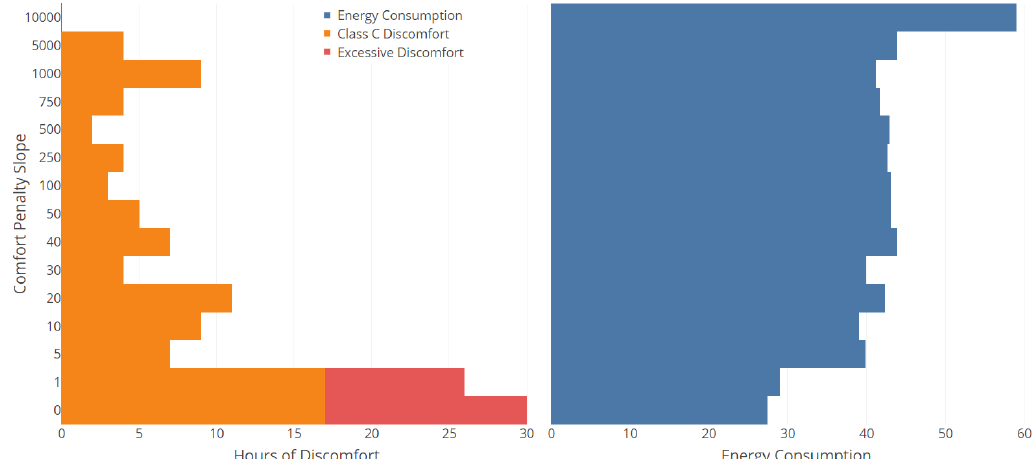
Figure 11. Resulting comfort and energy use, by comfort slope